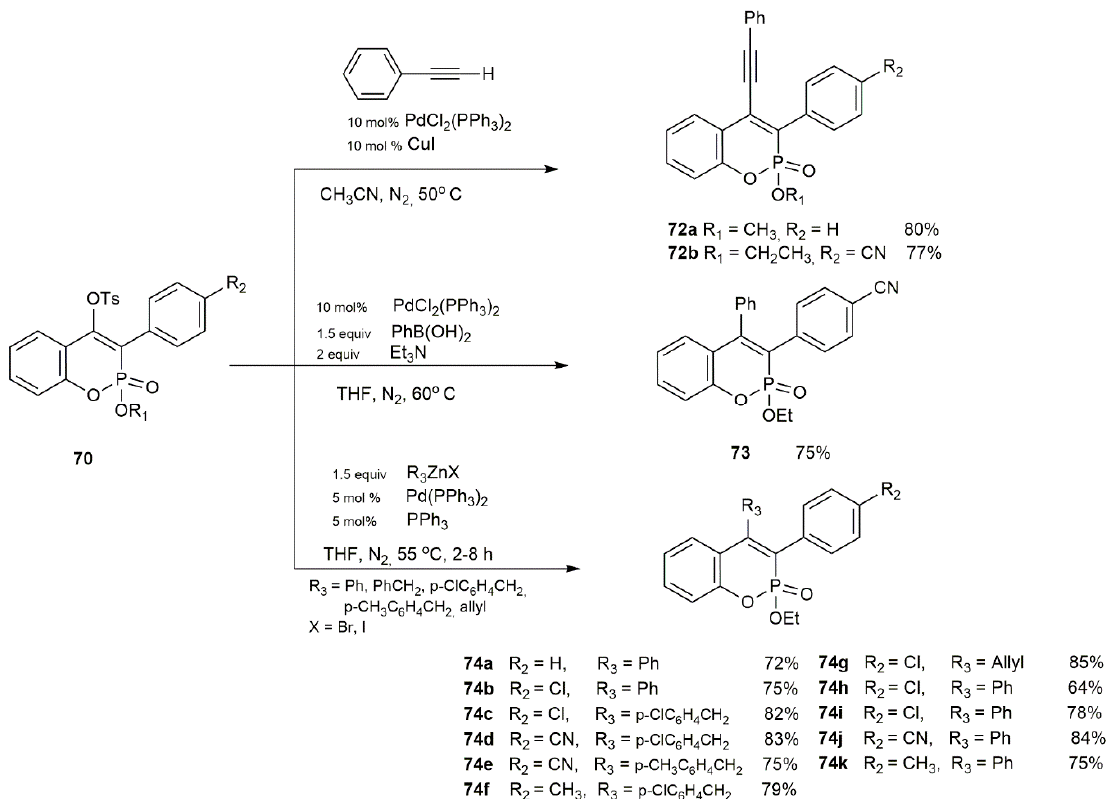
Scheme 47. Conditions and results for the coupling reactions.